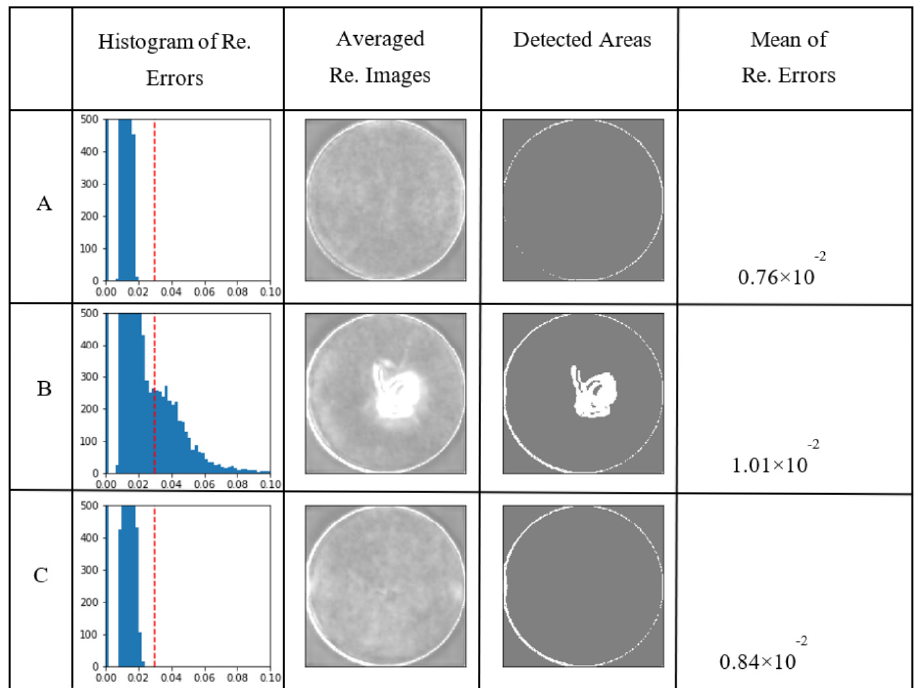
Figure 8. Detection of the irregular area using convolutional auto-encoder (proposed model). ( A – C ) corresponds to specimen (a), (b), and (c), respectively.